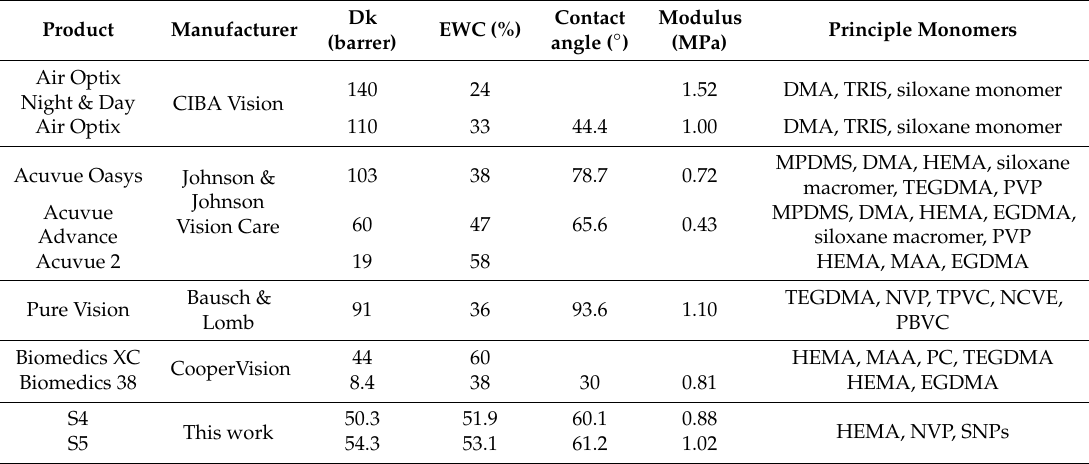
Table 2. Properties comparison of this study and commercial